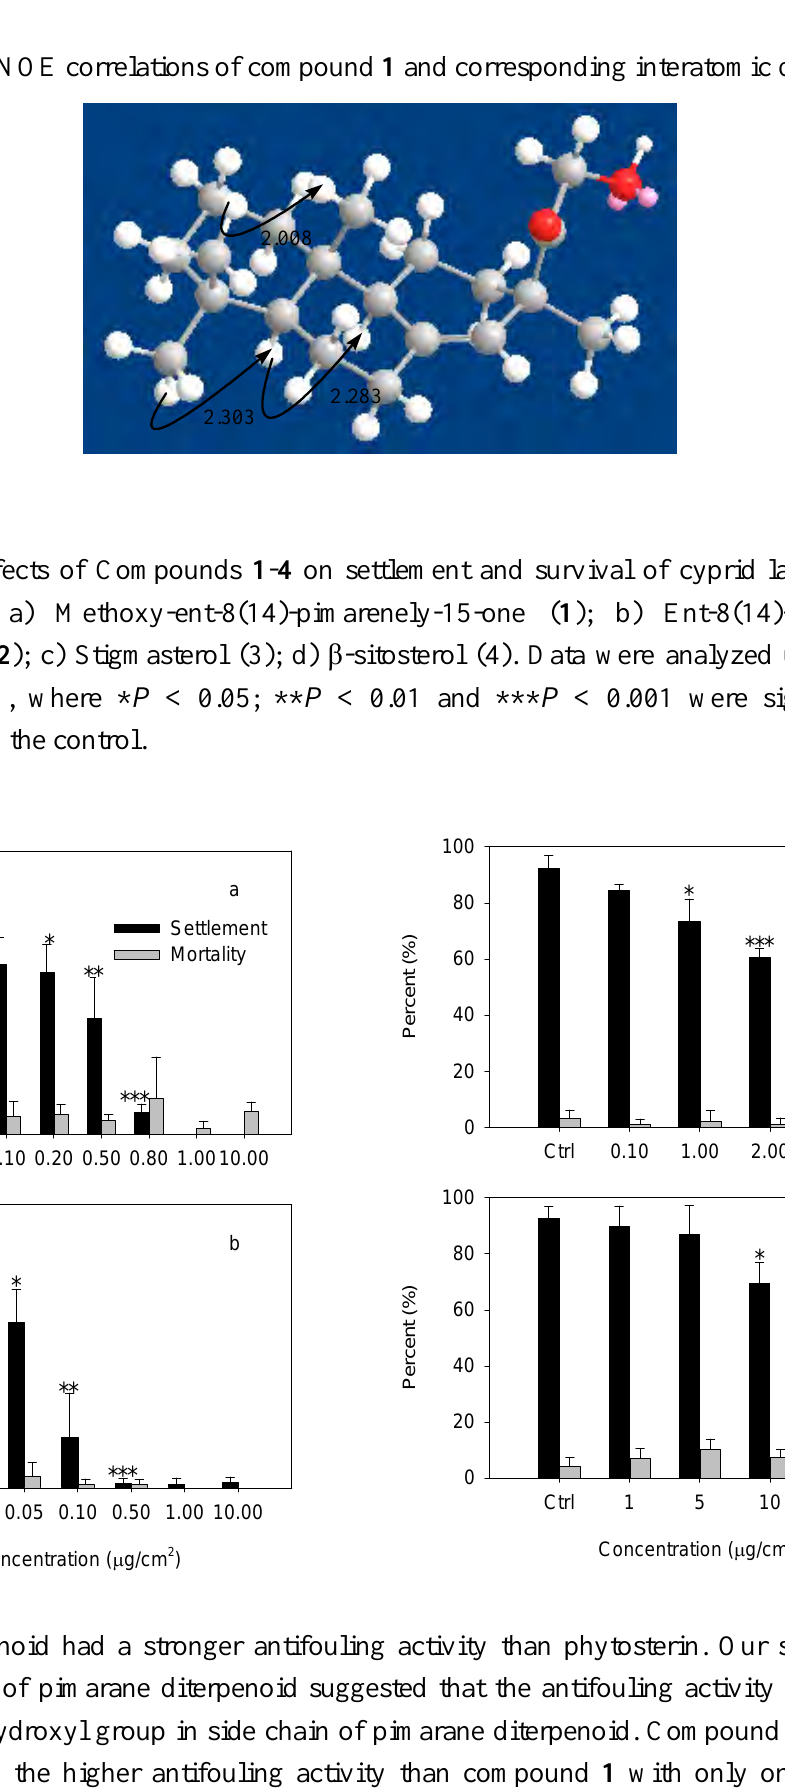
Figure 3. Key NOE correlations of compound 1 and corresponding interatomic distances ( Ǻ ).